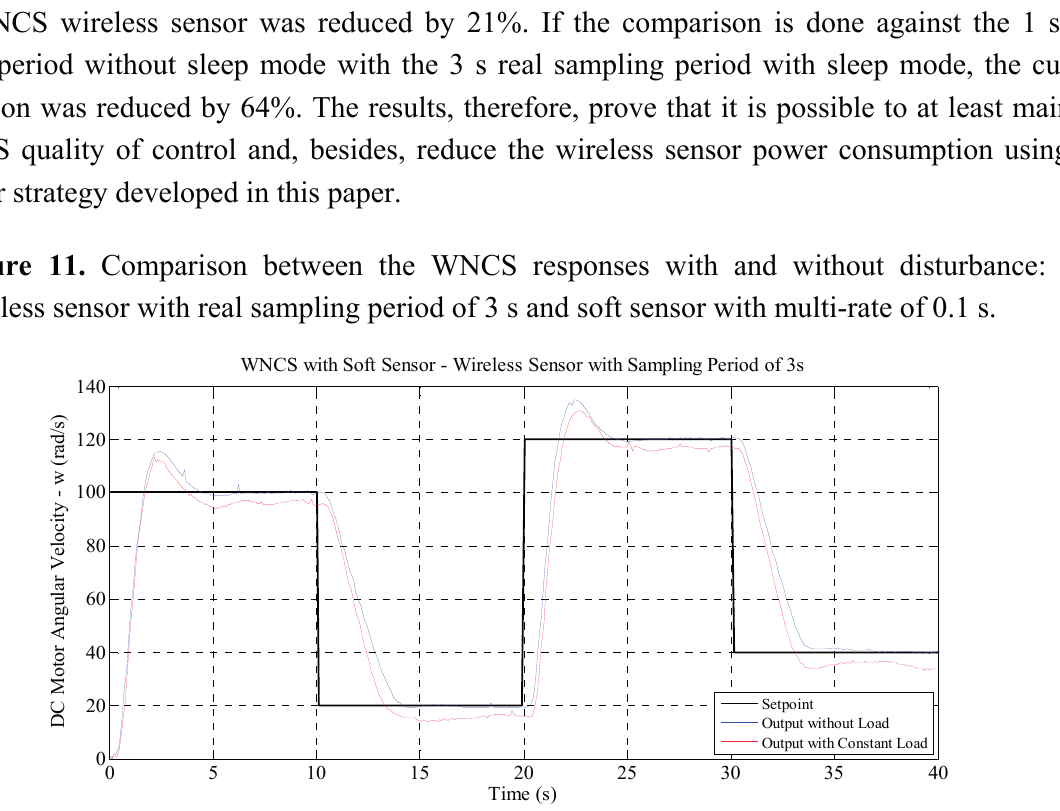
Setpoint Output without Load Output with Constant